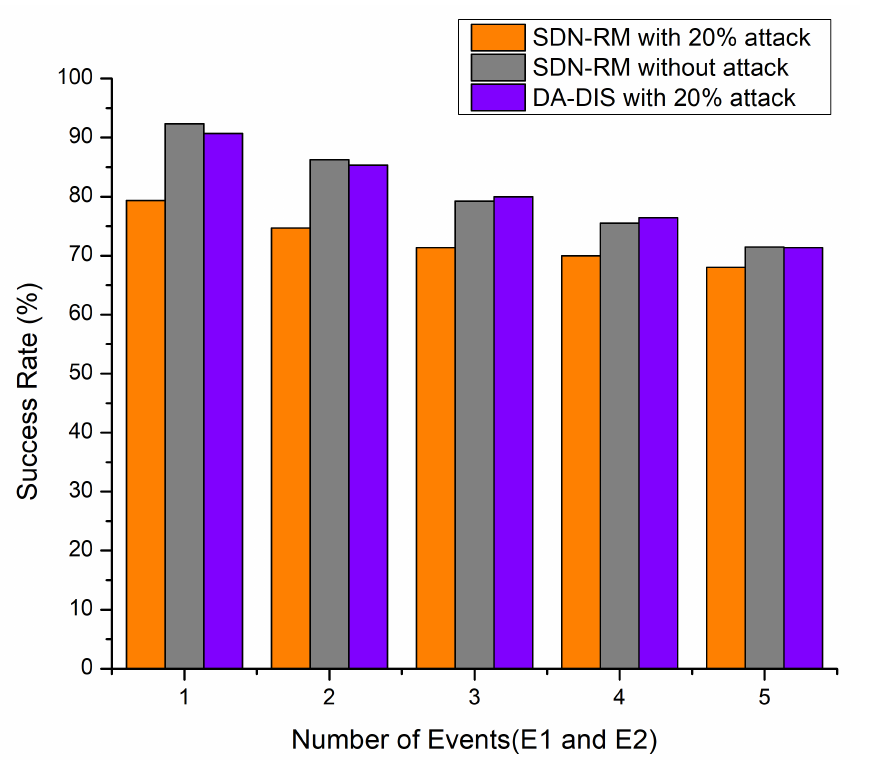
Figure 5. Success Rate considering a different number of events (E1 and E2) and 20% malicious switches.